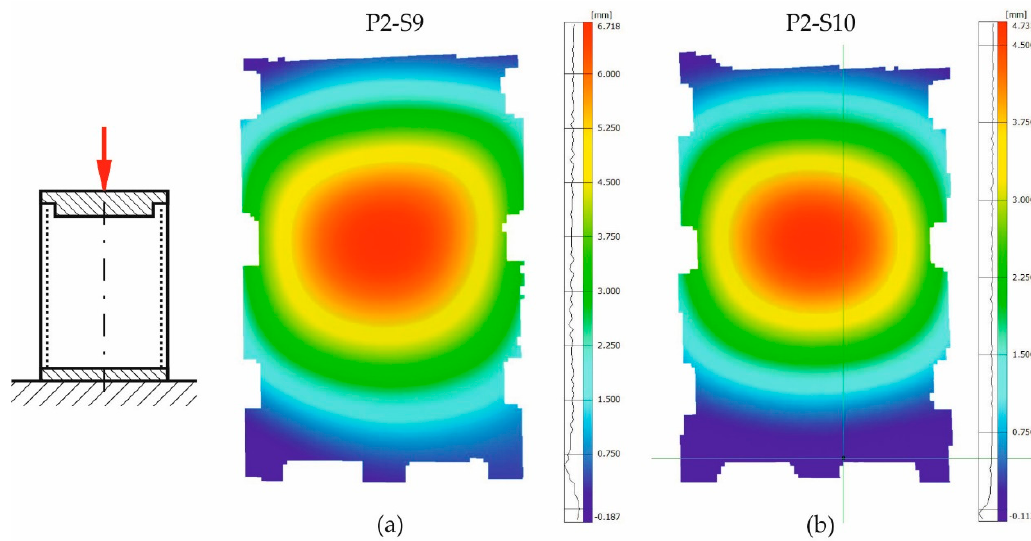
Figure A5. Qualitative illustration of out-of-plane displacement of specimen ( a ) P2-S9 and ( b ) P2-S10 measured with CAI-modified device.